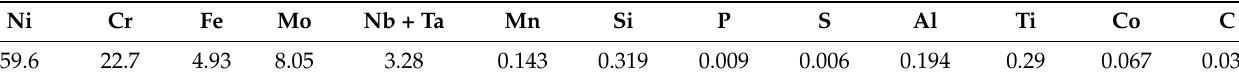
Table 1. Chemical composition of Inconel 625 alloy (wt.%).